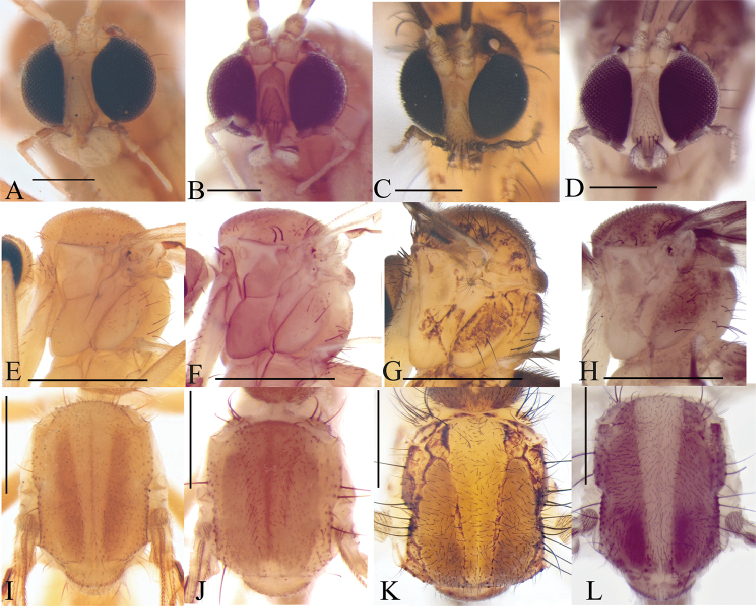
Head, frontal view AEudicrana
silvaandina sp. nov. (holotype) BE.
chingaza sp. nov. (holotype) CE.
maculata sp. nov., (holotype) DE.
merizaldei sp. nov. (holotype). Thorax, lateral view EEudicrana
silvaandina sp. nov. (holotype) FE.
chingaza sp. nov. (holotype) GE.
maculata sp. nov. (holotype) HE.
merizaldei sp. nov. (holotype). Thorax, dorsal view IEudicrana
silvaandina sp. nov. (holotype) JE.
chingaza sp. nov. (holotype) KE.
maculata sp. nov. (holotype) LE.
merizaldei sp. nov. (holotype). Scale bar: 0.25 mm.